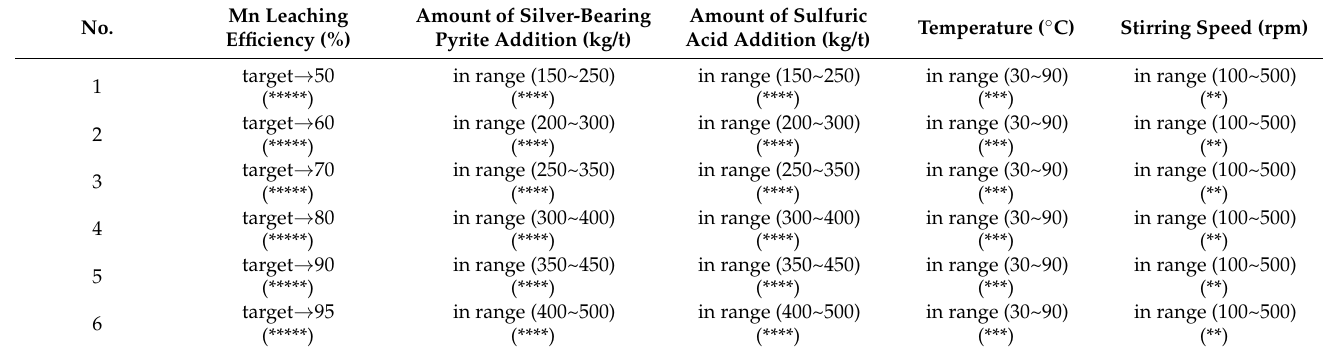
Table 6. The desired goals for all independent factors with ranges and importance (shown with the number of “*”, the more “*”, the more importance) on Mn leaching efficiency.